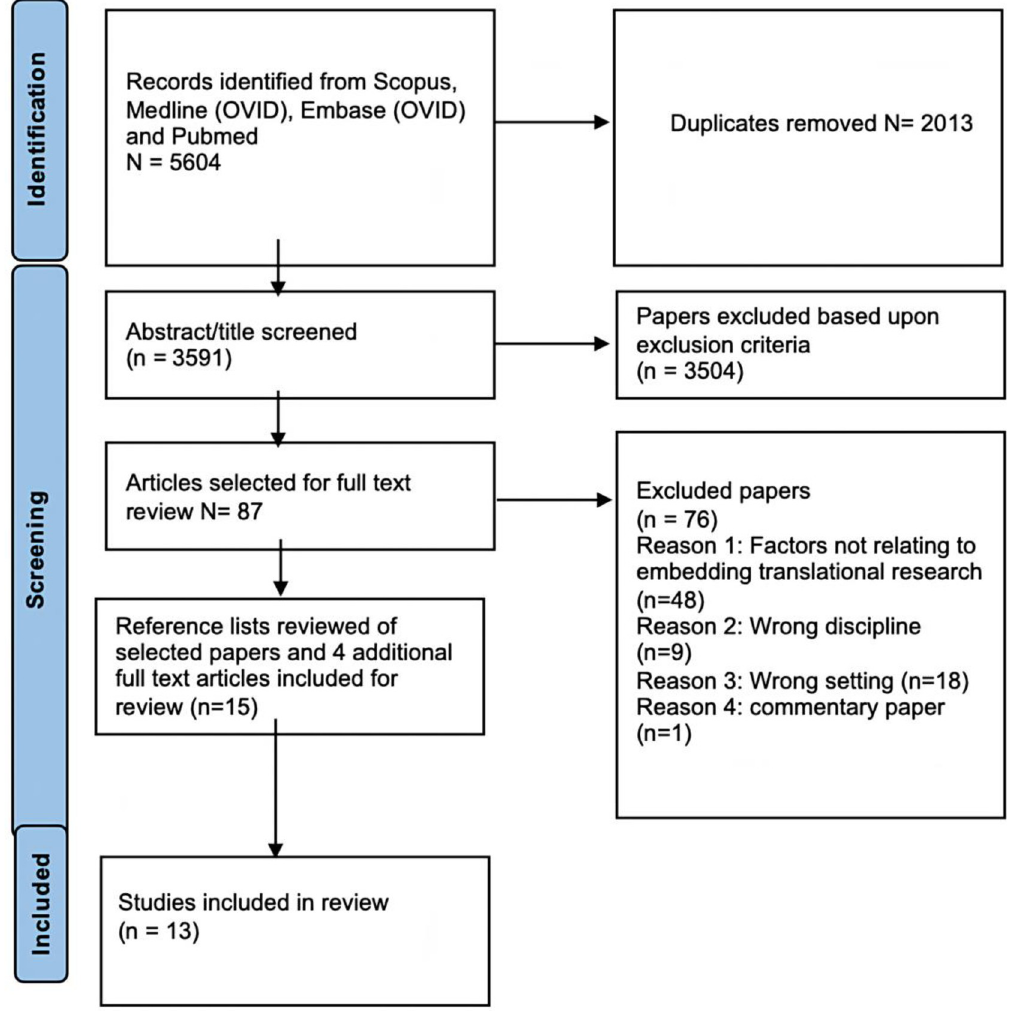
Fig 1. PRISMA flowchart of the literature search and selection